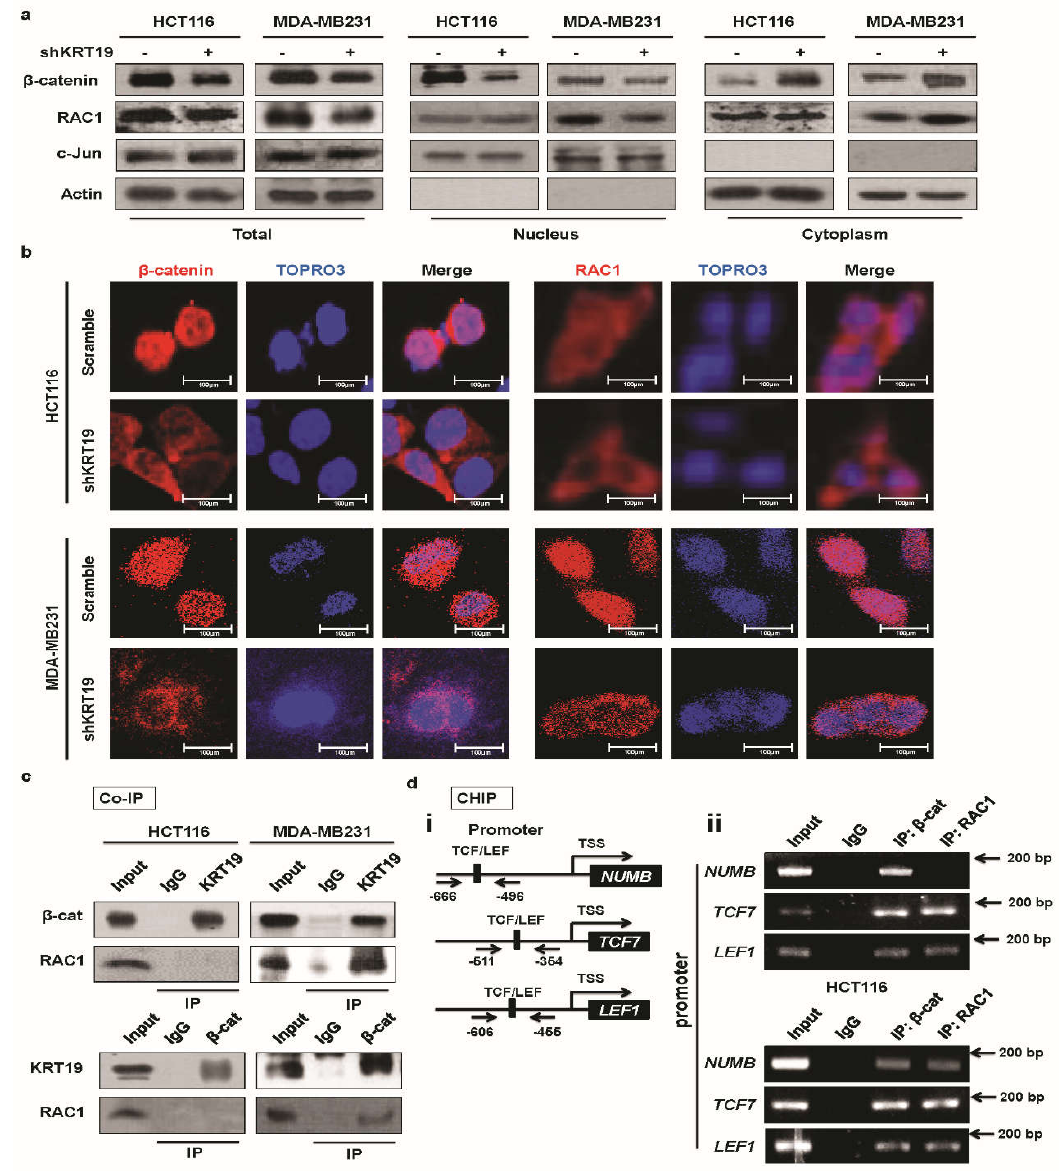
Figure 5. KRT19 differentially regulates β -catenin/RAC1 localization and directly interacts with either β -catenin or the β -catenin/RAC1 complex in colon and breast cancer cell lines. ( a ) Cell fractionation assay for β -catenin and RAC1 analyzed by Western blot; actin and c-Jun were used as the cytoplasmic and nuclear markers, respectively, in the indicated cells. ( b ) β -catenin and RAC1 subcellular localizations were analyzed using an immunocytochemistry (ICC) assay in the indicated cells. Photos were taken under an inverted confocal microscope. Scale bar used in photos is 100 µ m. Red: β -catenin/RAC1; Purple: TOPRO3. ( c ) Co-immunoprecipitation (Co-IP) was performed using Protein A/G Sepharose and antibodies specific for KRT19, β -catenin, and RAC1, or normal IgG in the indicated cancer cells. Cell lysates were analyzed by Western blot. ( d ) Schematic representation of NUMB , TCF7 , and LEF1 promoters that contain TCF/LEF binding sequences ( i ). Expression of NUMB , TCF7 , and LEF1 promoters was analyzed in the indicated cells by RT-PCR using a ChIP assay after pulldown of normal IgG, β -catenin, and RAC1 ( ii ). Sonicated chromatin lysate was used as the input.